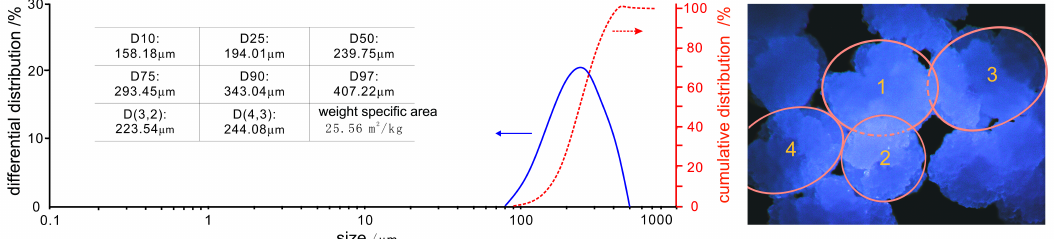
Figure 3. Size distribution ( left ) and mesostructure (( right ), × 300) of the coalescence particulates of the composite pressure-activated sealant. The 3D morphology of the grown coalescence particulates is marked. The red line corresponds to cumulative distribution of particulates in the sealant, and the purple circles mark the profile of agglomeration